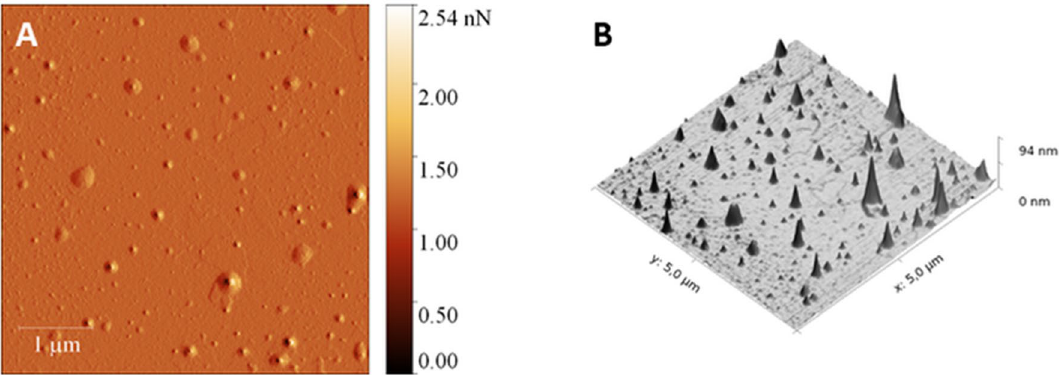
Figure 3. AFM 2D topography ( A ) and the corresponding 3D reconstructions ( B ) images of TPP-NPs. Scan area: 3.3 µm × 3.3 µm). Images were processed by Gwydion 2.40.